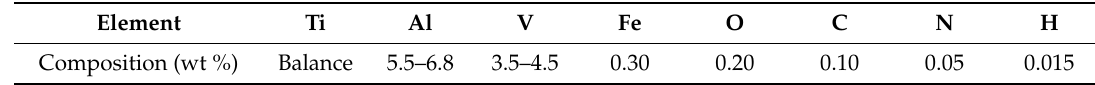
Table 1. Chemical composition of Ti6Al4V.